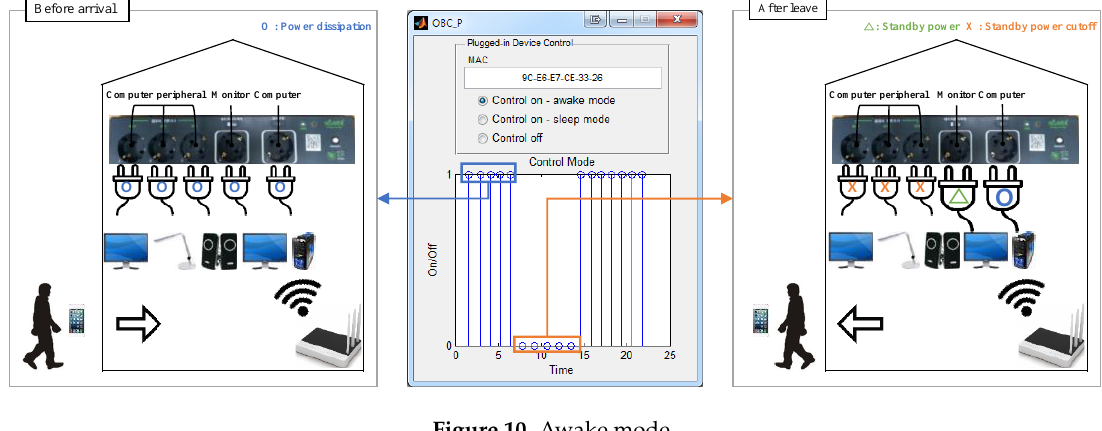
Figure 10. Awake mode.